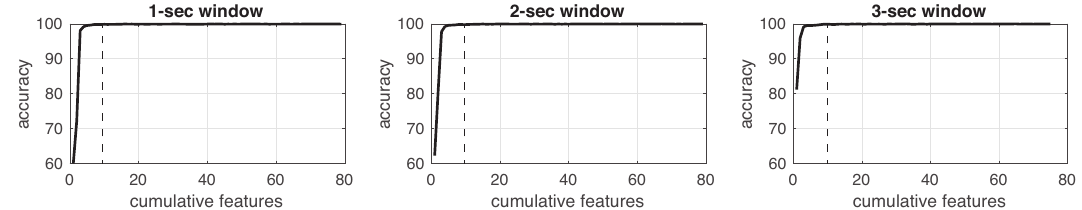
Figure 9. Accuracy performance on training using cumulative features for Experiment 2 : IMU. From left to right, it presents the performance using: 1-second length windowing, 2-second length windowing and 3-second length windowing. The dash line reports the number of cumulative features employed for the next steps.